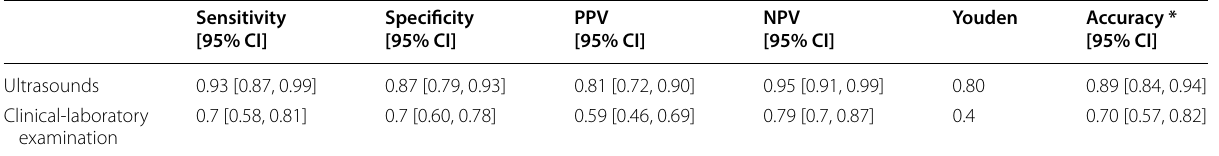
Table 3 Performance of ultrasound and clinical-laboratory examination according to the final diagnosis of surgical